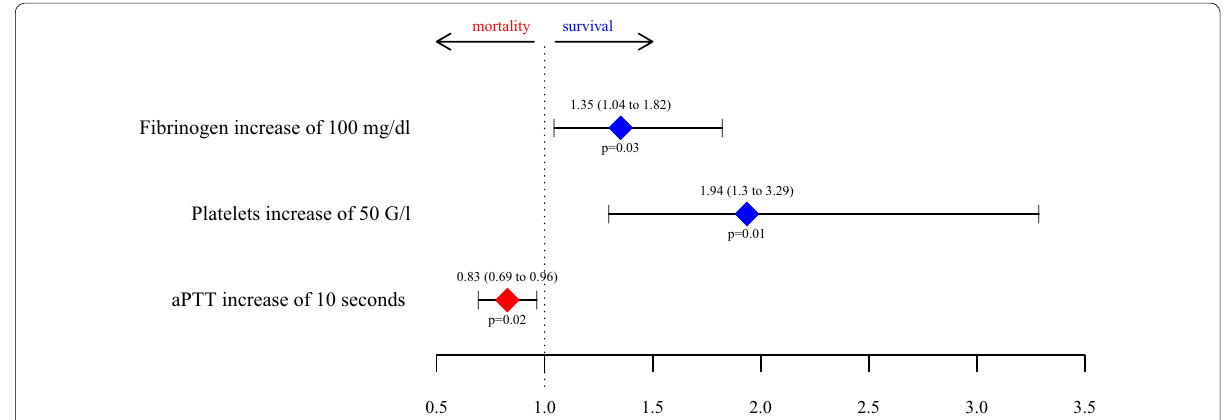
Fig. 3 Adjusted odds ratios (95% CI) for survival retrieved from logistic regression. For an odds ratio greater than 1, an increase in the parameter decreases the mortality risk